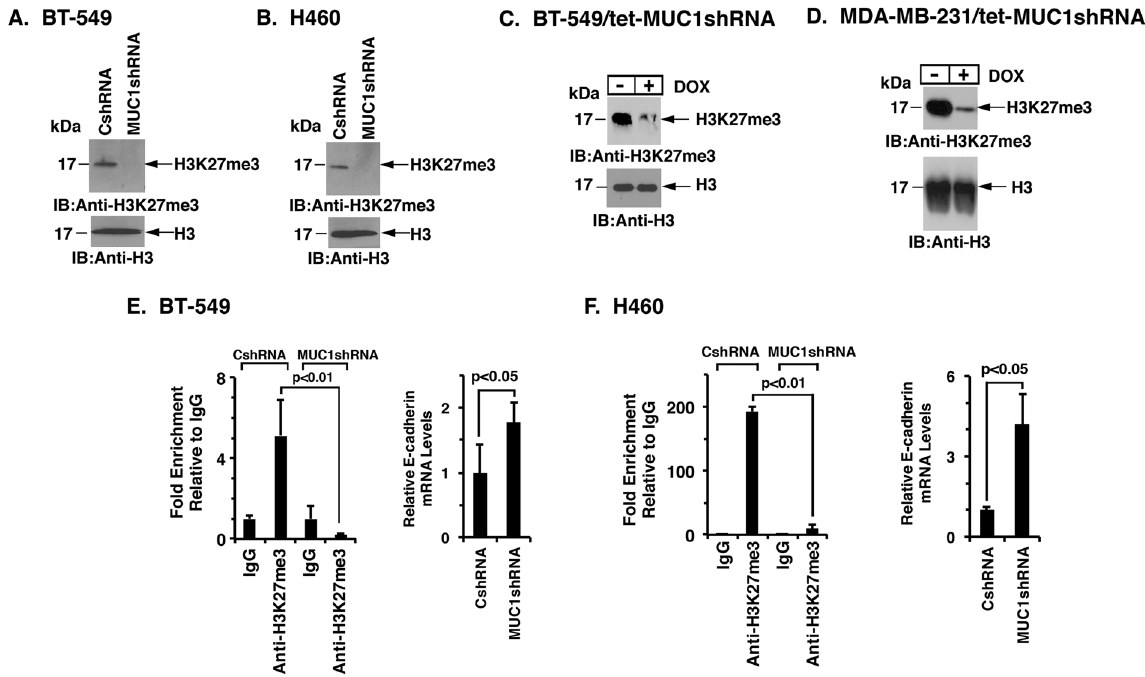
Figure 6. Targeting MUC1-C represses global and CDH1 promoter-specific H3K27me3 levels. ( A and B ) Lysates from the respective BT-549 ( A ) and H460 ( B ) cells expressing a CshRNA or MUC1shRNA were immunoblotted with anti-H3K27me3 and anti-histone H3. ( C and D ) Lysates from BT-549/tet-MUC1shRNA ( C ) and MDA-MB-231/tetMUC1shRNA ( D ) cells treated with 200 ng/ml DOX for 4 d were immunoblotted with the indicated antibodies. E and F. Soluble chromatin from the respective BT-549 ( E ) and H460 ( F ) cells expressing a CshRNA or MUC1shRNA was precipitated with anti-H3K27me3 or a control IgG. The final DNA samples were amplified by qPCR with primers for the CDH1 promoter. The results (mean ± SD of three determinations) are expressed as the relative fold enrichment compared with that obtained with the IgG control (assigned a value of 1) (left). Cells were also analyzed for E-cadherin mRNA levels by qRT-PCR using primers listed in Table S1. The results (mean ± SD) are expressed as relative mRNA levels compared to that obtained for the CshRNA cells (assigned a value of 1) (right). See also Fig.